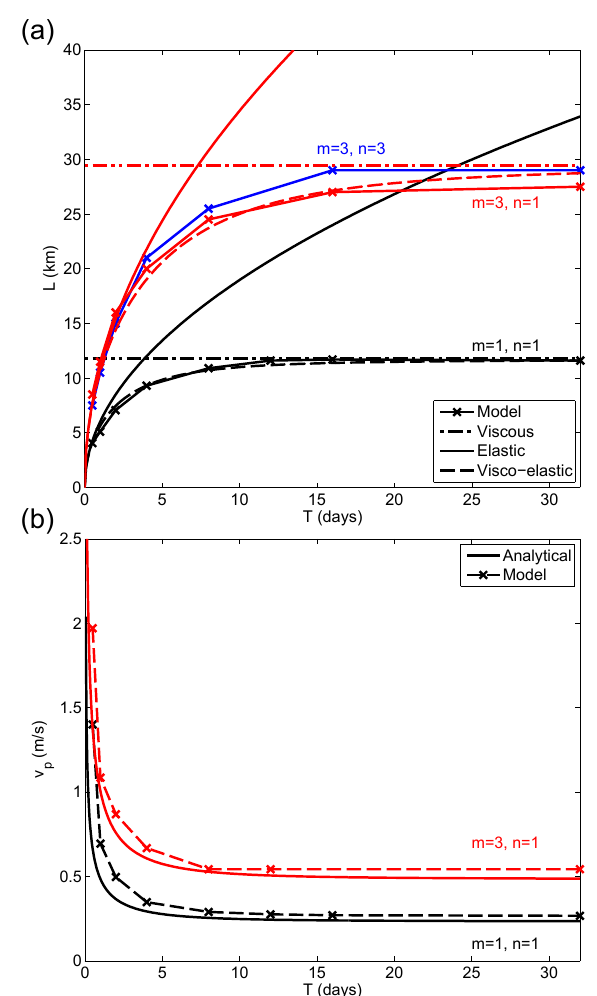
Figure 8. Comparison of analytical solutions for stress-coupling length scale (panel a ) and phase velocity (panel b ) with model re- sults. Solutions and results for linearised runs are shown in black, semi-nonlinear runs in red and fully nonlinear runs in blue. In panel (a) the solid and dot-dashed lines are the purely viscous and elastic length scales respectively as derived from the linearised SSA, and the dashed line is the combined viscoelastic response. The modelled length scales are the solid lines marked with crosses representing a model run for that given loading period. In panel (b) the phase ve- locity in the model (dashed line) was calculated by a least squares fit and compared to the analytical